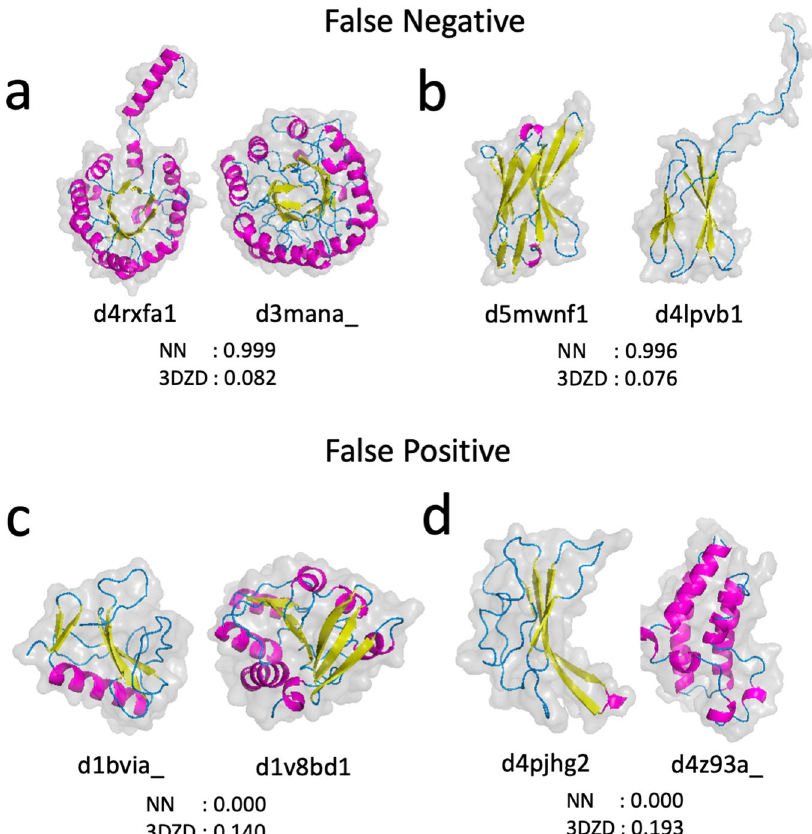
Fig. 5 Examples of pairs where 3DZD-NN classi fi ed correctly but 3DZD did not. Four protein structure pairs with the scores by 3DZD-NN and 3DZD are shown. The main-chain atom representation was used for these comparisons. The two pairs on panel a and b are cases where 3DZD did not recognize them as the same fold (i.e. false negative) but 3DZD-NN did. a d4rxfa1 and d3mana_ belong to the TIM beta/alpha-barrel (SCOP code: c.1). 3DZD-NN had a probability score of 0.99, i.e. very con fi dent that these two structures belong to the same fold while 3DZD had a score of 0.082, below the detection threshold of 0.1. b d5mwnf1 and d4lpvb1, belong to Immunoglobulin-like beta-sandwich (b.1). Panel c and d shows two pairs, where 3DZD-NN correctly detected that the two structures have different folds while 3DZD had a score above the threshold of 0.1 and thus considered them as the same fold. Fold assignment of the four structures in SCOP are as follows: c , d1bvia_: Microbial ribonucleases (d.1); d1v8bd1: NAD(P)-binding Rossmann-fold domains